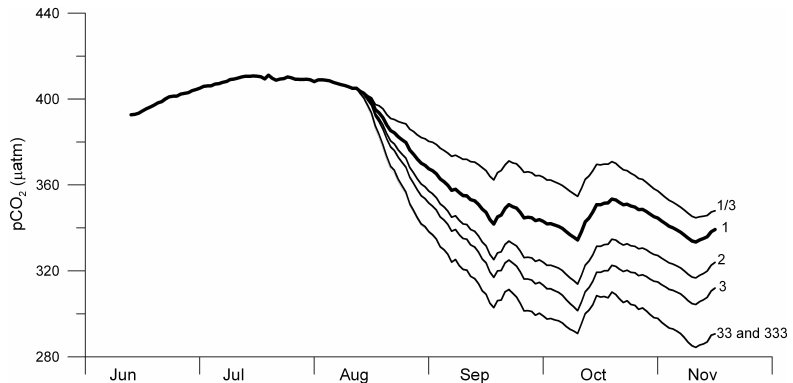
Fig. 15. Modelled p CO 2 , SW at Papa with different iron supply rates. The factors are related to the volcanic ash fertilisation run with factor of 1 which equals 7.25µmolm − 2 (reference experiment), iron input factor of 1/3 equals 2.42µmolm − 2 , factor of 2 equals 14.5µmolm − 2 , factor of 3 equals 21.75µmolm − 2 , factor of 33 equals 239.25µmolm − 2 , and factor of 333 equals 2414.25µmolm − 2 .